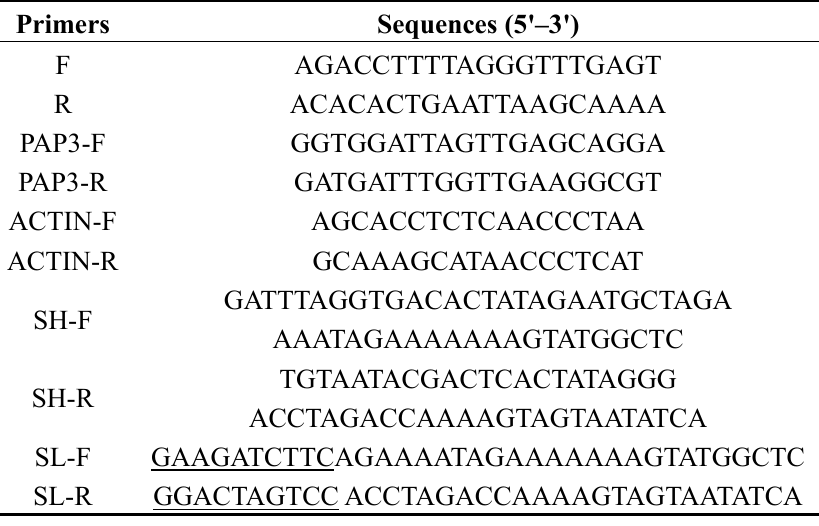
Table 1. Primers for expression analyses of PAP3